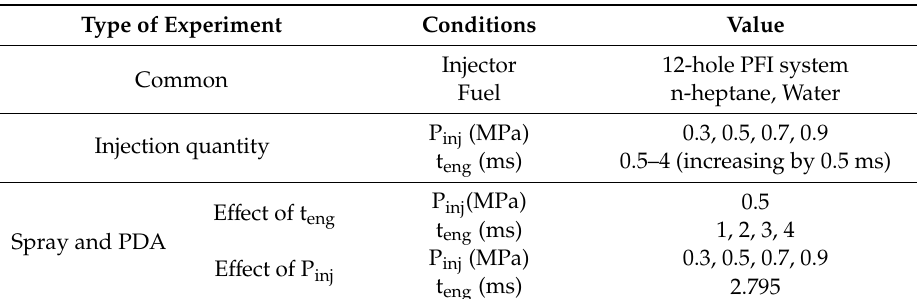
Table 2. Experimental